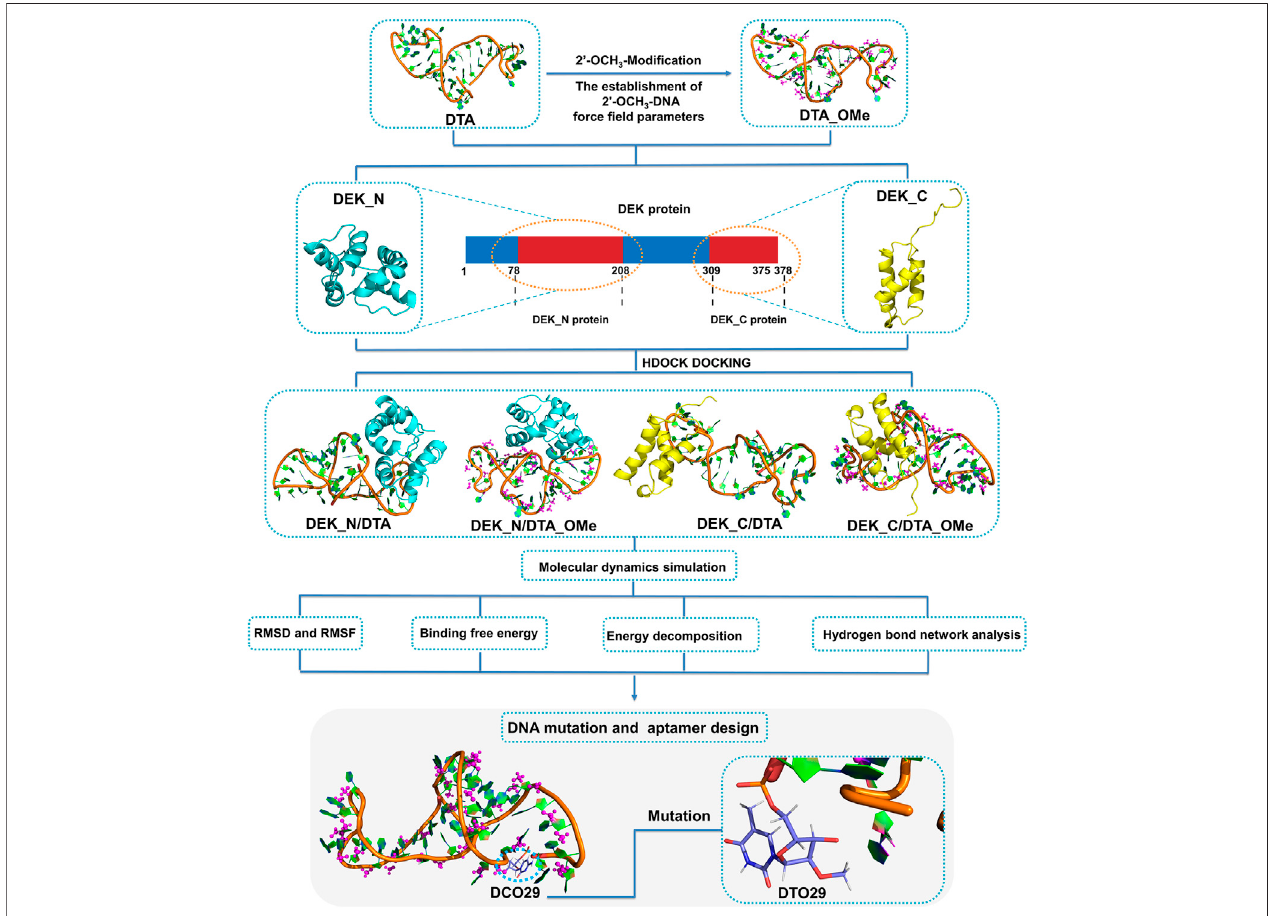
FIGURE 1 | Schematic illustration of the interaction mechanisms and the new aptamer design. DEK_N and DEK_C respectively represent the N-terminal and C-terminal structural domains of the human DEK protein. DTA_OMe is obtained by modifying the 2 ′ -position of all deoxyribose on the DTA with methoxy groups. Four complex models (DEK_N/DTA, DEK_N/DTA_OMe, DEK_C/DTA, and DEK_C/DTA_OMe) got through the cross docking between these two terminal proteins and the two